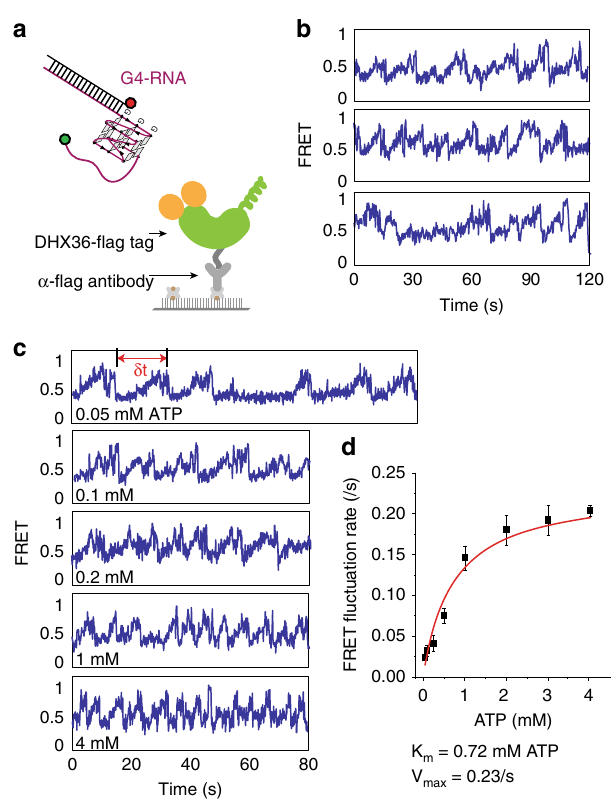
Fig. 2 The repetitive DHX36 activity is monomer-driven and ATP dependent. a Experimental scheme for the reciprocal assay in which single molecules of DHX36 were immobilized to surface and FRET labeled G4- RNA was added. b Representative smFRET traces. c smFRET traces taken at varying concentrations of ATP from lowest (top) to the highest